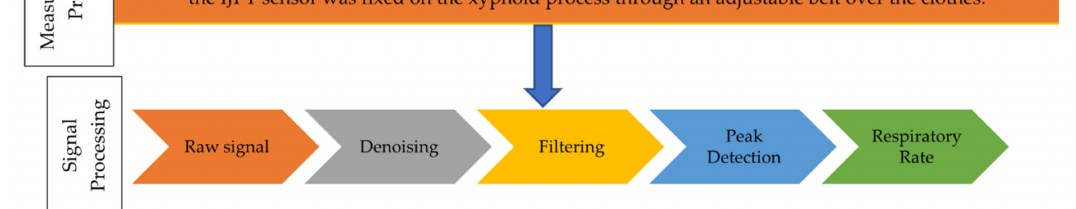
Figure 1. Schematic diagram of the inkjet-printed (IJPT) sensor fabrication process and respiratory rate (RR) extraction on Chronic Obstructive Pulmonary Disease (COPD)